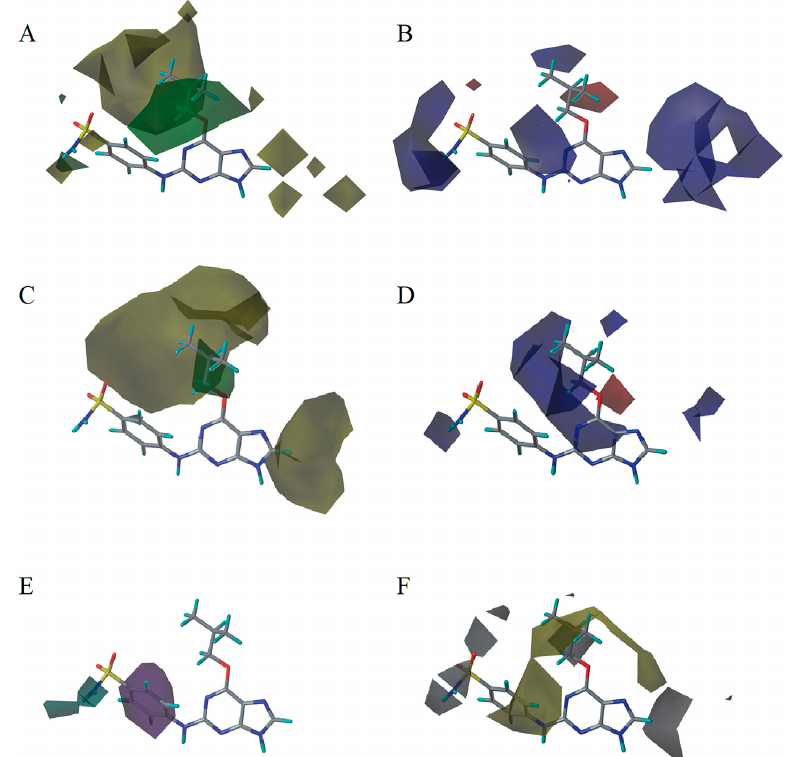
Figure 4. Contour maps of the optimal CoMFA and CoMSIA models. ( A ) CoMFA steric contour. ( B ) CoMFA electrostatic contour. ( C ) CoMSIA steric contour. ( D ) CoMSIA electrostatic contour. ( E ) CoMSIA hydrogen bond donor contour. ( F ) CoMSIA hydrophobic contour. Steric bulk favored areas that are in green and unfavorable areas in yellow ( A , C ). Electropositive favored areas are in blue and electronegative favored areas are in red ( B , D ). The hydrogen bond donor favored areas that are in cyan and unfavorable areas that are in purple ( E ). Hydrophobic favored areas are in green and unfavorable areas are in white ( F ).